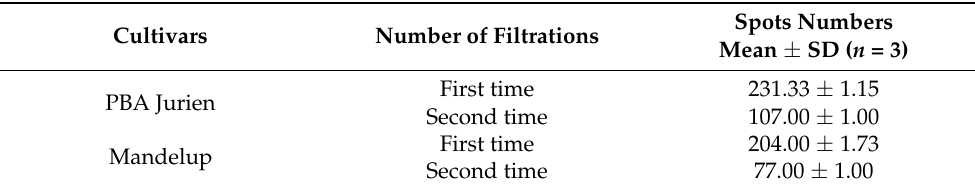
Figure 1. Diagram showing the workflow for lupin milk and cheeses processing technology. Table 1. Number of protein spots detected by PDQuest software from 2D-PAGE gels of lupin milk of each